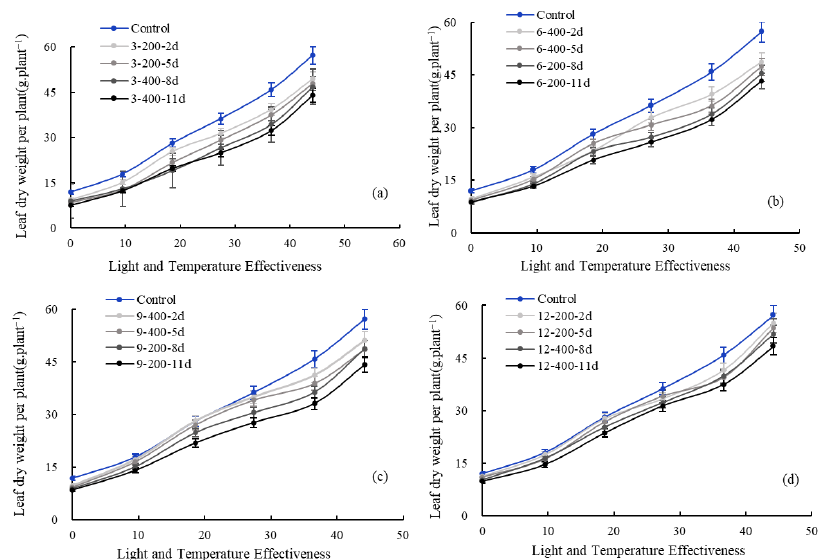
Figure 4. Variation trend of leaf dry weight of cucumber under LT and PL stresses. ( a ) Changes in dry weight of single cucumber leaves with LTE under 3 °C treatments. ( b ) Changes in dry weight of single cucumber leaves with LTE under 6 °C treatments. ( c ) Changes in dry weight of single cucumber leaves with LTE under 9 °C treatments. ( d ) Changes in dry weight of single cucumber leaves with LTE under 12 °C treatments. Note: Control represents the variation in leaf dry weight per cucumber plant with the increase in LTE under normal growth conditions.